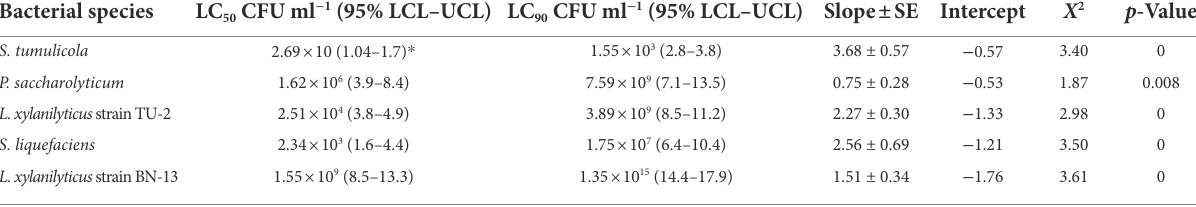
* Each figure represented as a power of 10. LC 50 , lethal concentration that killing 50% of insects; LC 90 , lethal concentration that kills 90% of insects; LCL, lower confidence limit; UCL, upper confidence limit; X 2 , Chi-square value; SE, standard error; and p -value,